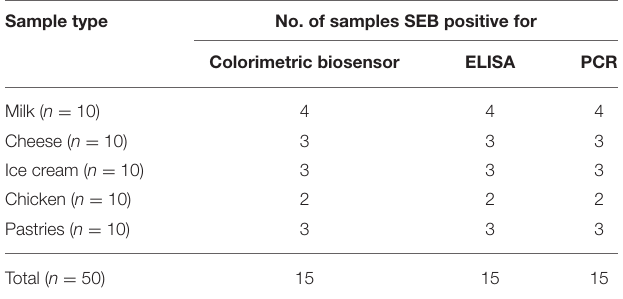
TABLE 2 | Analysis of natural samples for enterotoxin B through Colorimetric biosensor. Sample